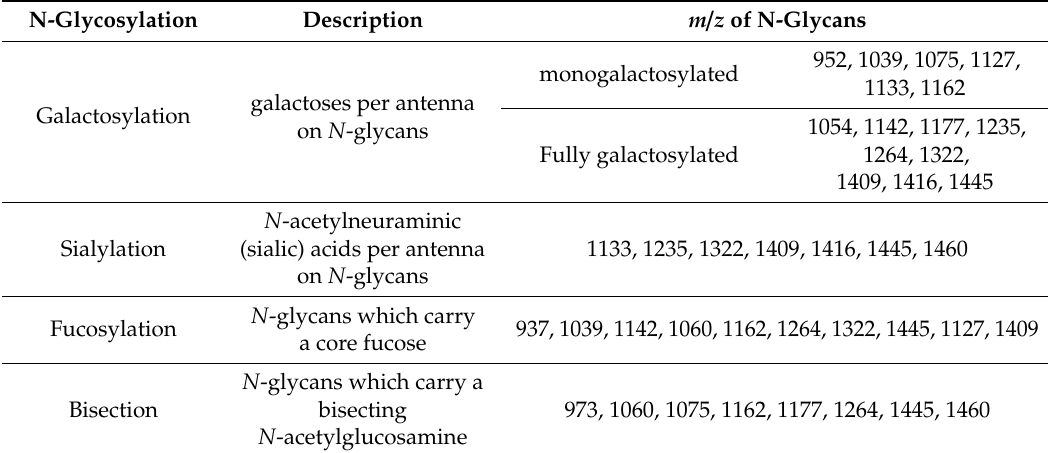
Table 3. A review of the description for the N-glycosylation feature.